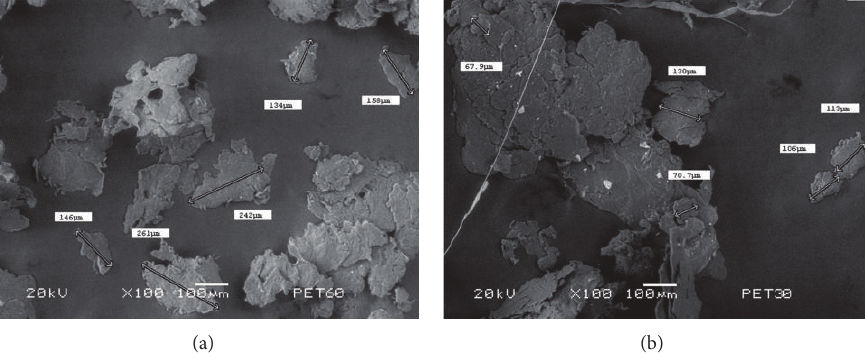
Figure 1: SEM images of (a) cut PET and (b) grinded PET.